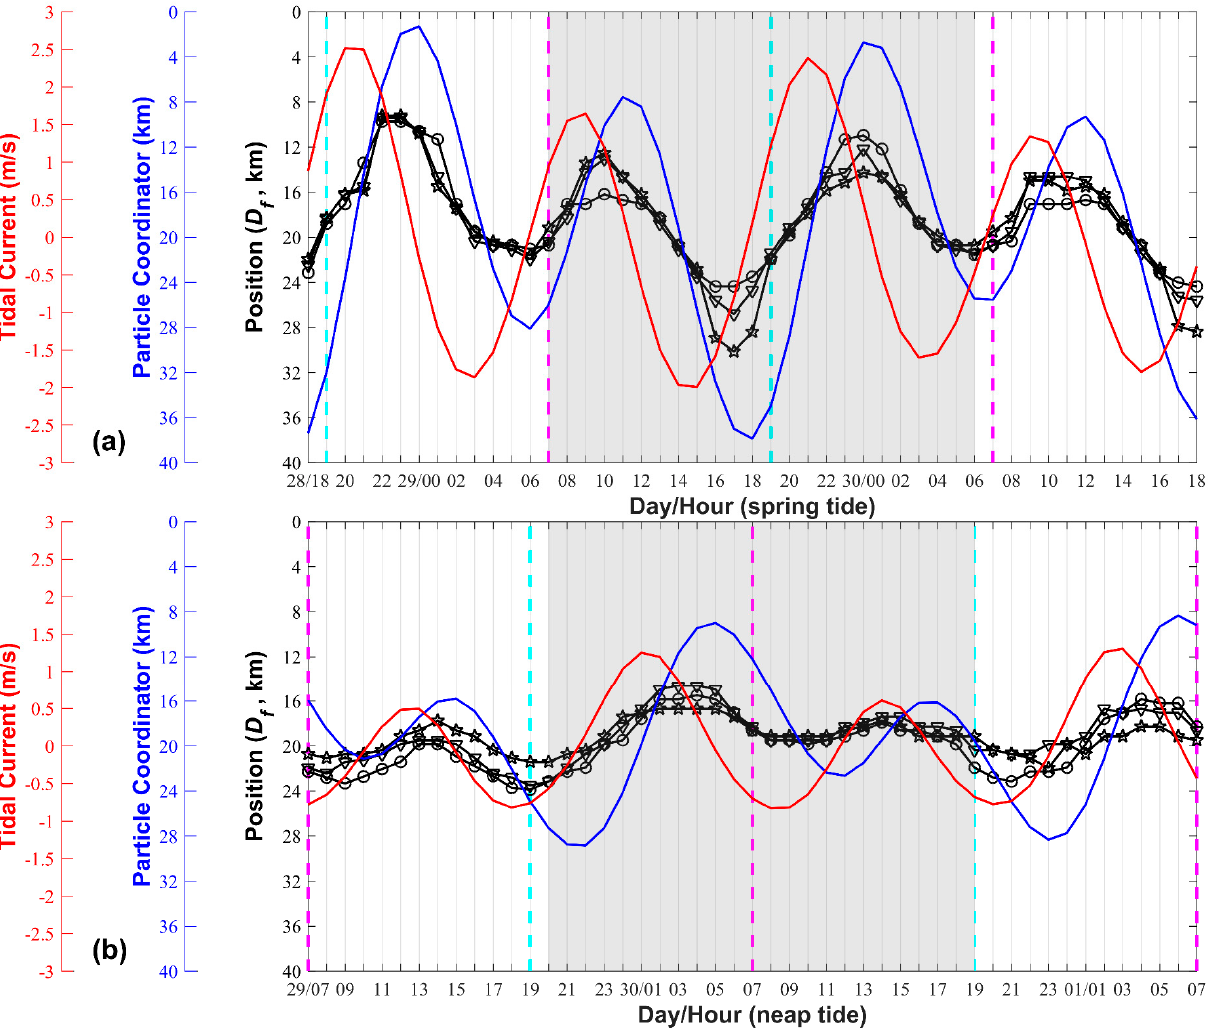
Figure 7. Predicted tidal current at the Hayasui Strait (red line), particle coordinator calculated by the tidal current velocity predicted by Equation (2) (blue line), and the front position ( D f , distances from the center point of the strait to the tidal front of the star, triangle, and circle symbols in Figures 3 and 4) during the ( a ) spring tide and ( b ) neap tide periods of Figures 3 and 4, respectively. Positive tidal current values indicate northward flow. The black lines with the circle, triangle, and star symbols represent the distance of the front from the center of the strait, D f , of the black circle, triangle, star symbols in Figures 3 and 4. The time series length is 48 h, and the shaded periods in ( a ) and ( b ) correspond to the data shown in Figures 3 and 4. The pink and cyan dotted lines indicate time of sunrise and sunset, respectively.